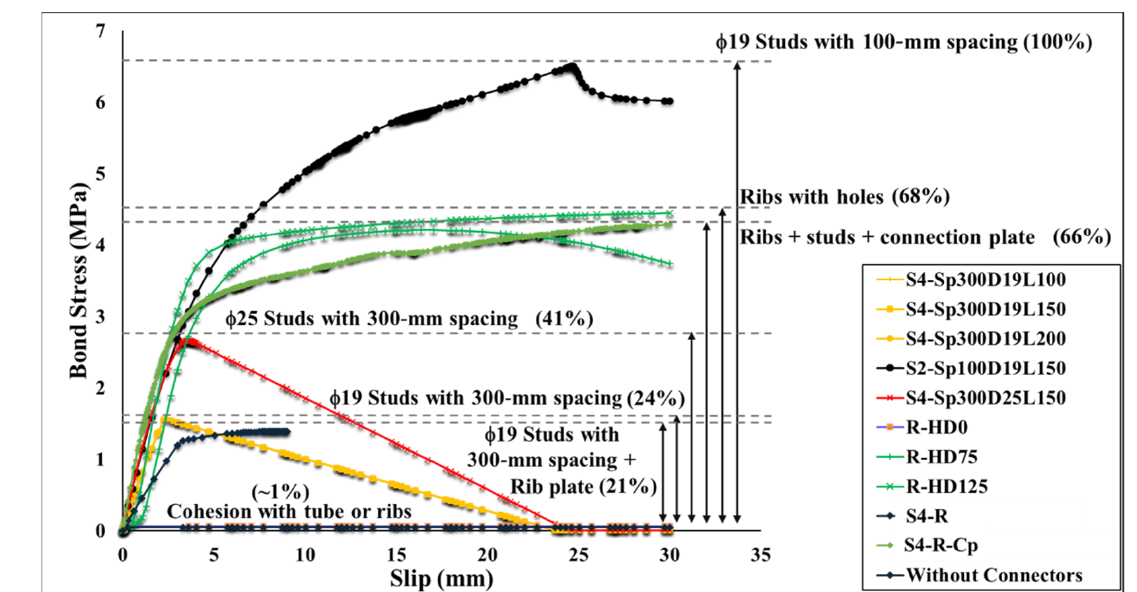
Figure 10. Bond stress–slip curve.